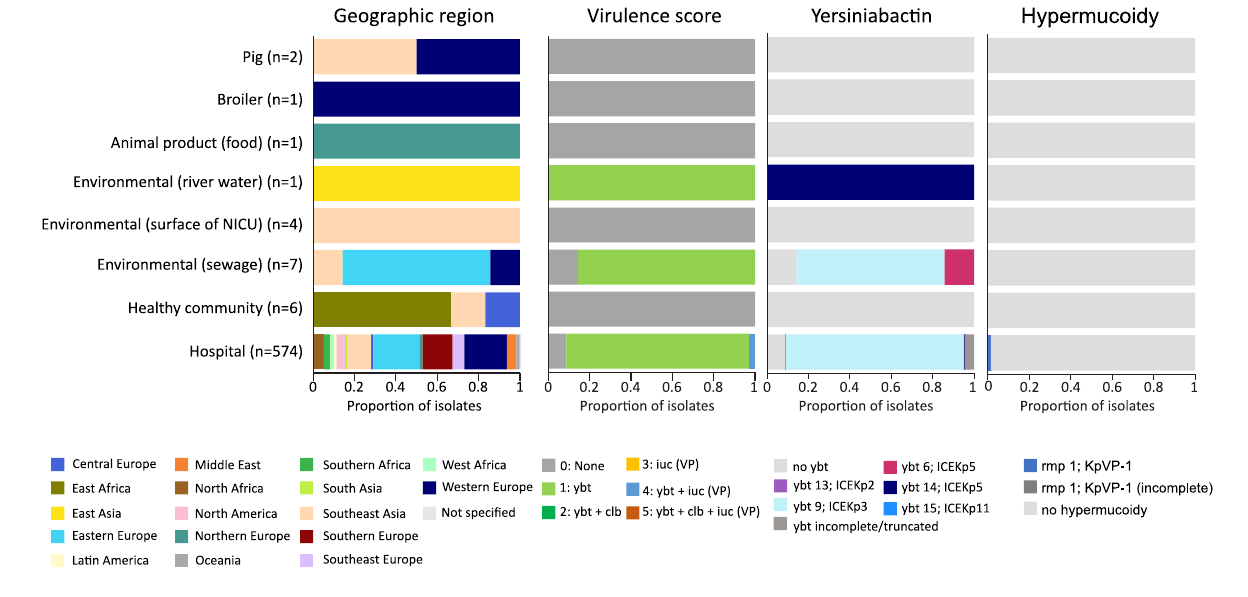
Frontiers in Microbiology |